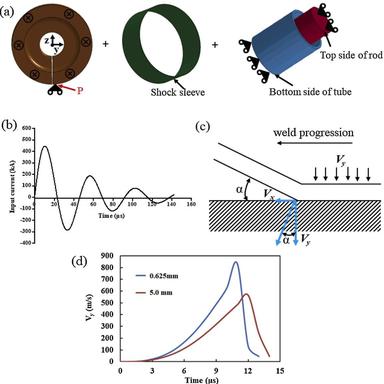
(a) Boundary conditions and (b) input current used in the coupled electromagnetic-mechanical simulation; (c) Illustration of the angle measurement convention used in this study, where Vx is the horizontal component of the impact velocity and Vy is the vertical component of the impact velocity; (d) Vy versus time curves obtained from CEMM model at two different locations.